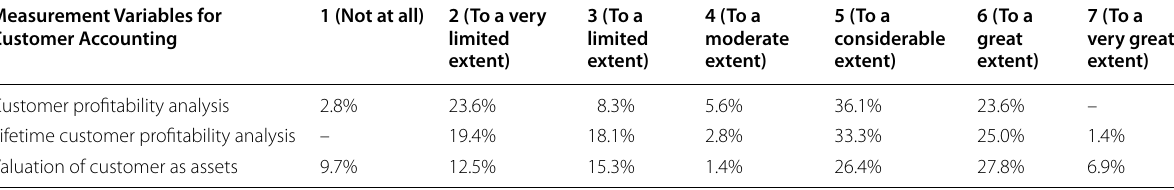
Table 8 Frequency distribution for customer accounting usage (CAU) ( n Measurement Variables for Customer Accounting